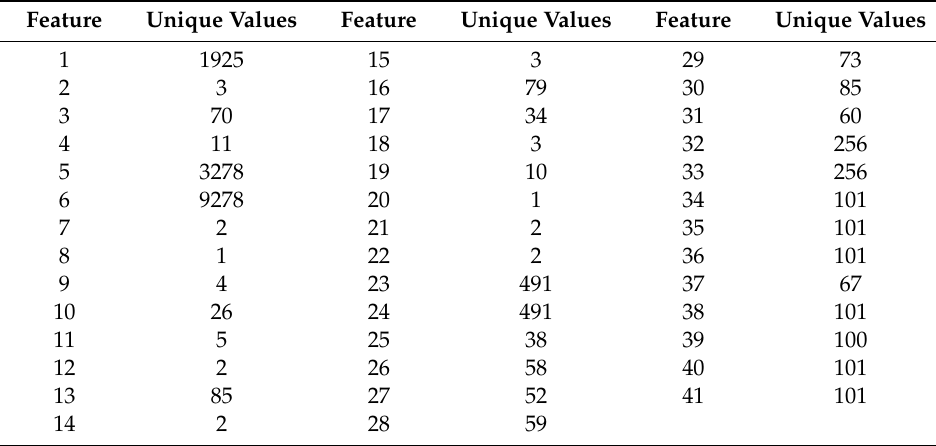
Table 1. Unique values of features of NSL-KDD in training normal data.